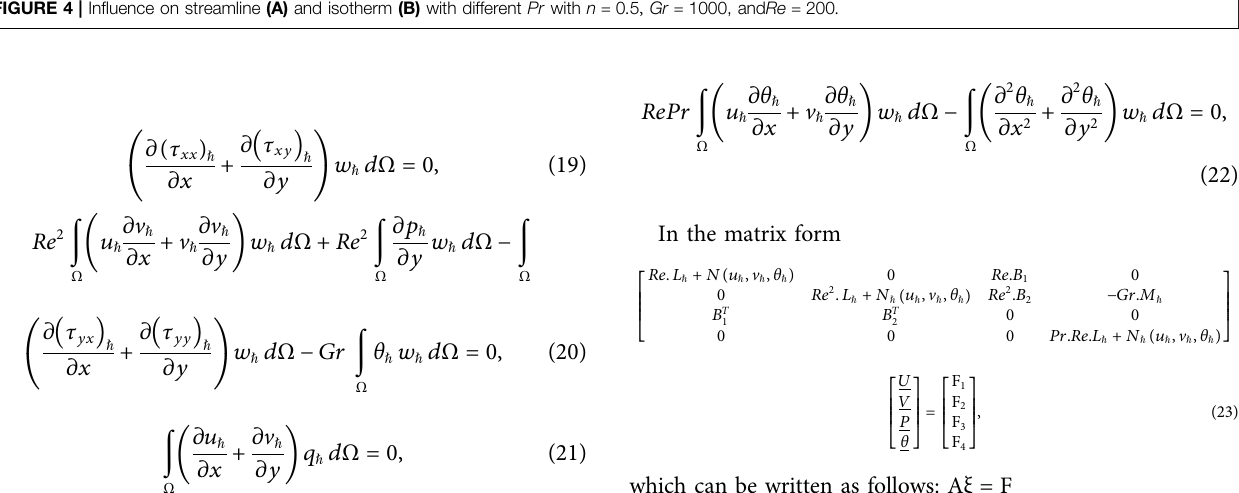
Frontiers in Physics |